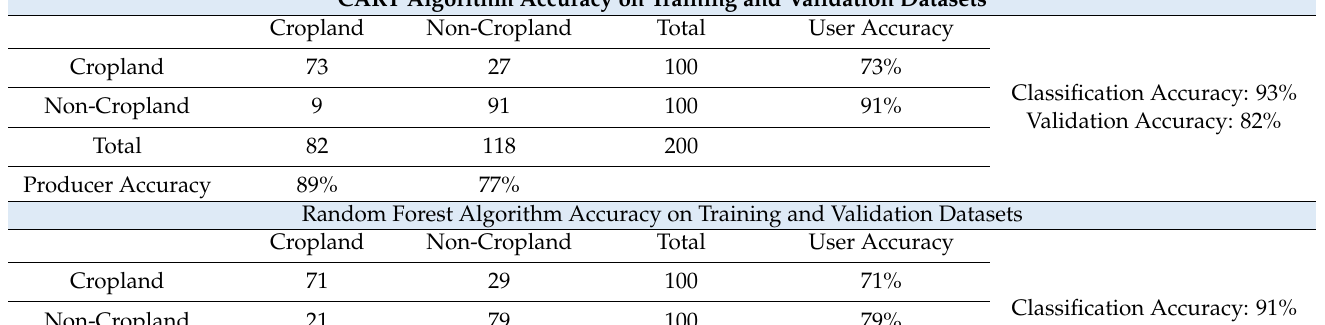
Table 4. The computer analysis performance error matrix algorithms. The 10 m to 60 m cropland expanded commodity for Pakistan’s precision error matrix. CART Algorithm Accuracy on Training and Validation